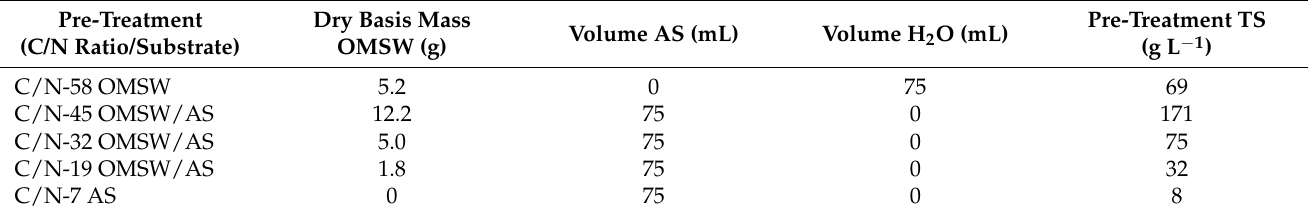
Table 1. Mixture conditions for the pre-treatment of Olive mill solid waste and Aquaculture